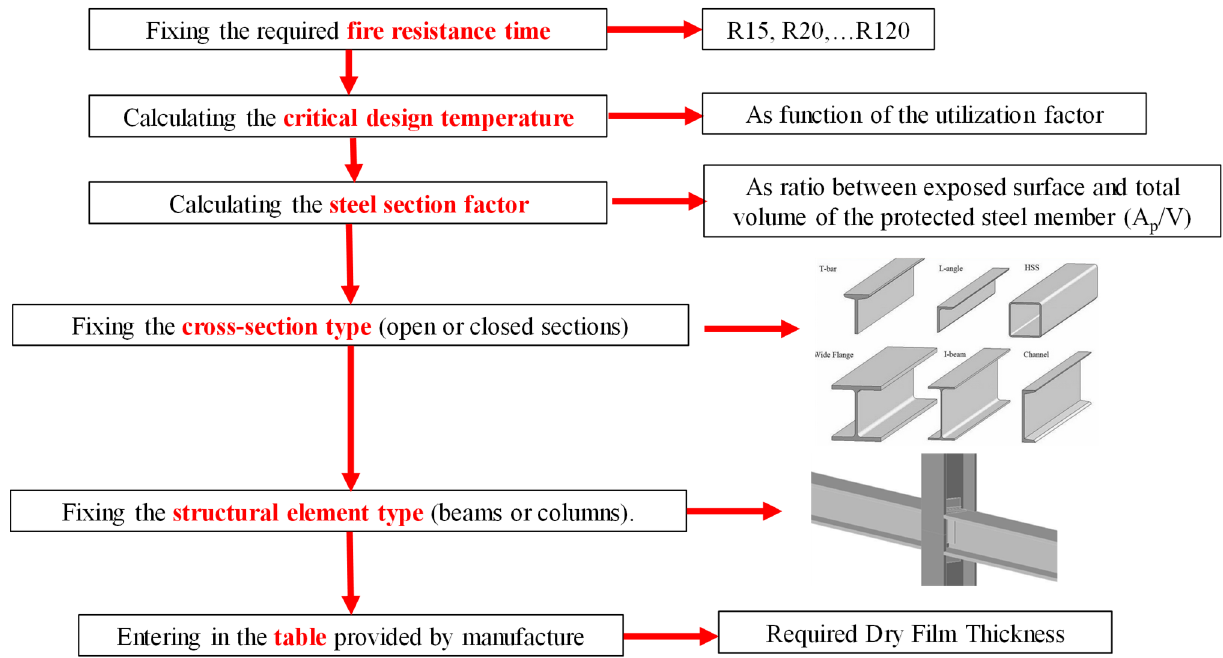
Figure 7. The main step for designing IC thickness.